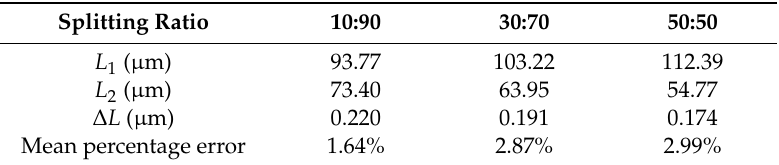
Table 2. MZDC design parameters.